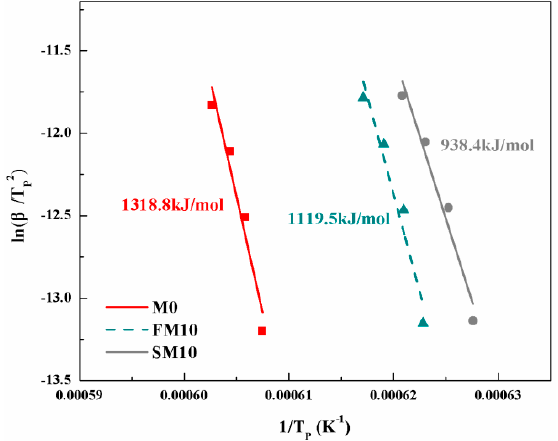
Figure 4. The crystallization activation energies of the different ceramic cores.